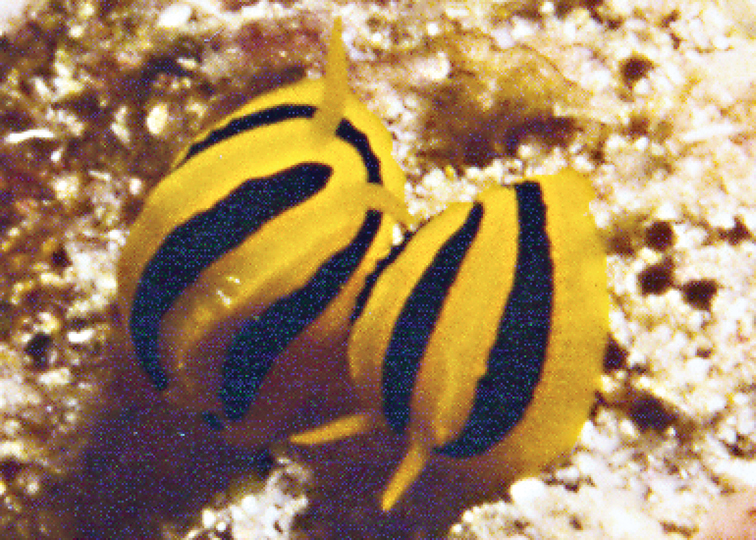
Phyllidia koehleri, 10 mm, Maldives, photo: J Hinterkircher.